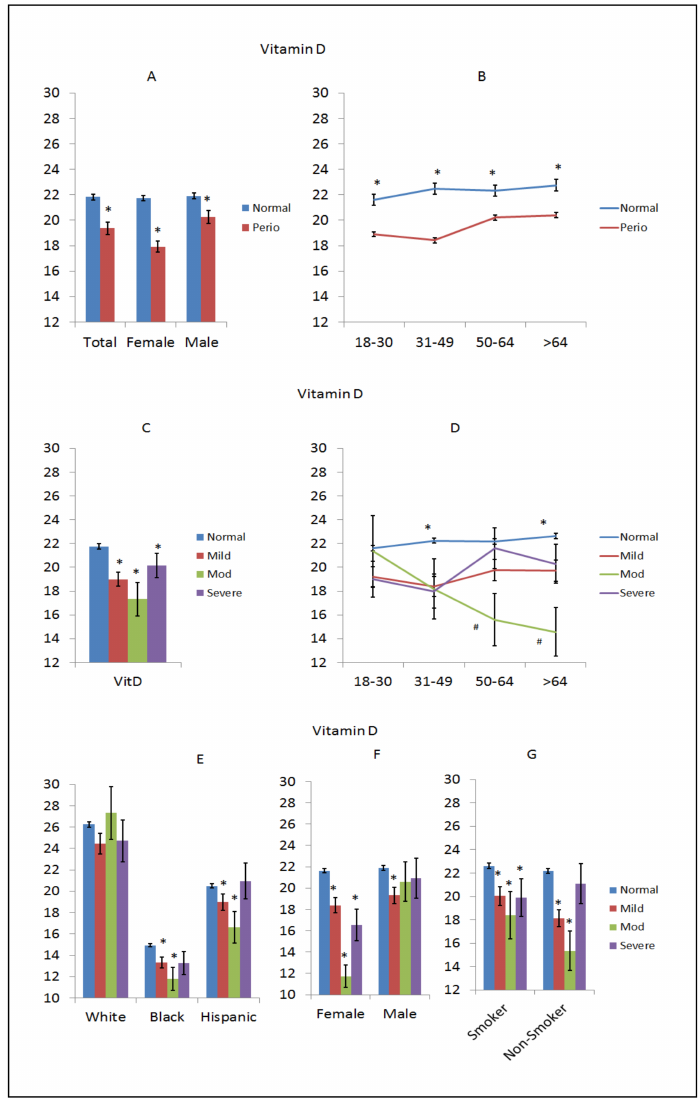
Figure 4. Levels of vitamin D (ng/mL) in subjects with or without periodontitis stratified upon sex ( A ), age ( B ), disease severity ( C ), disease severity and age ( D ), race/ethnicity ( E ), disease severity and sex ( F ), and disease severity in smokers ( G ). The bars denote group means and the vertical brackets enclose 1 SEM. The asterisk (*) denotes significantly different than the normal group at p <